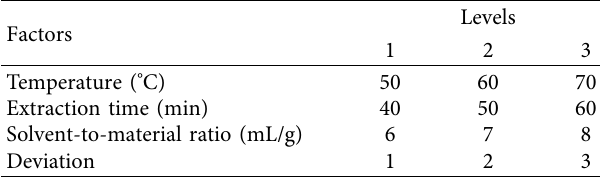
Table 2: Independent variables and their